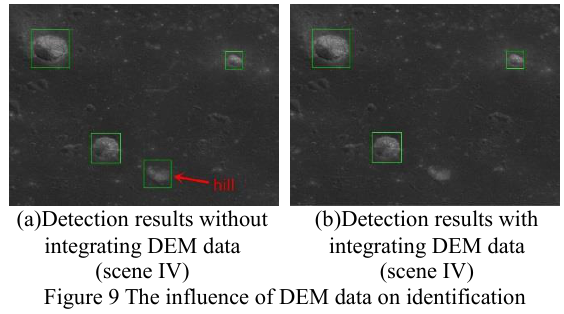
Figure 9 The influence of DEM data on identification